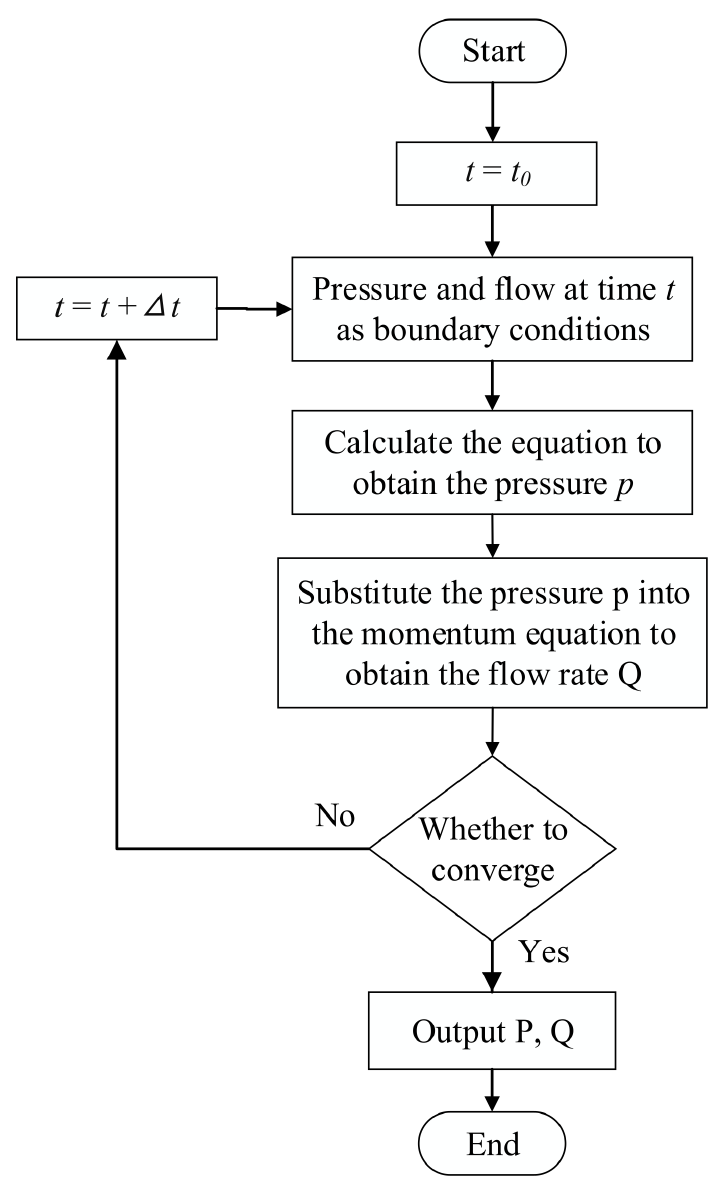
Figure 3. Schematic diagram of calculation process using fluid network